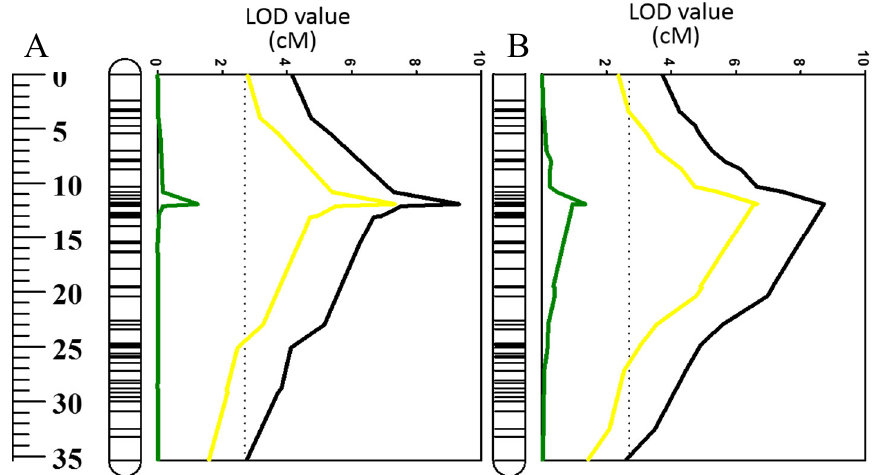
Figure 7. QTL associated with ( A ) superoxide (O 2 •− ) in the mature zone and ( B ) hydrogen peroxide (H 2 O 2 ) in elongation zone tolerance (LOD values) on 2HS. Black line: LOD value of original QTL; green line: LOD value of QTL when salinity tolerance was used as a covariate; yellow line: LOD value of QTL when waterlogging was used as a covariate.